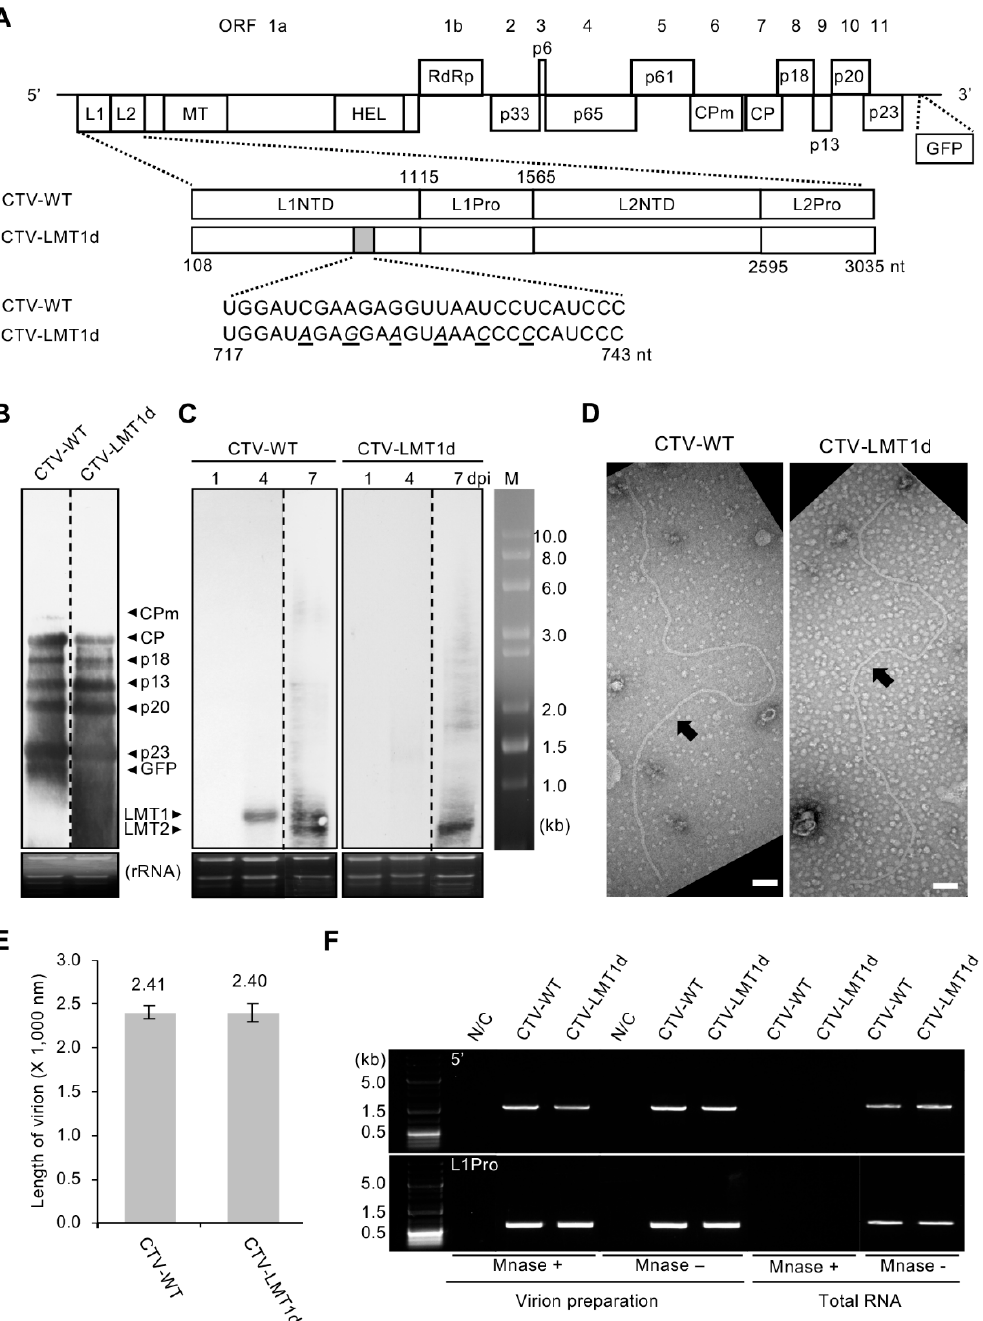
Figure 1. Prevention of LMT1 production does not affect virus ability to replicate or assemble proper virions. ( A ) Schematic representation of pCTV-WT and pCTV-LMT1d. The boxes represent reading frames (ORFs) and their translated products. L1 and L2, papain-like leader proteases; NTD, n - terminal domain; Pro, C-terminal proteolytic domain; MT, methyltransferase; HEL, helicase; RdRp, RNA-dependent RNA polymerase; p65, HSP70 homolog; CPm, minor coat protein; CP, coat protein. The silent nt mutations (shown as underlined italicized letters) introduced to modify the controller element of LMT1 (grey box) are shown in detail under the enlarged genome segment. All viruses have a green fluorescent protein (GFP) ORF inserted between the p23 gene and the 3’ non-translated region of the Citrus tristeza virus (CTV) genome. ( B , C ) Northern blot analysis of the total RNA isolated from N. benthamiana plants expressing CTV-WT and CTV-LMT1d hybridized with the 3’ positive-strand RNA-specific probe ( B ) or 5’ positive-strand RNA-specific probe ( C ). Total RNA used in ( B ) was